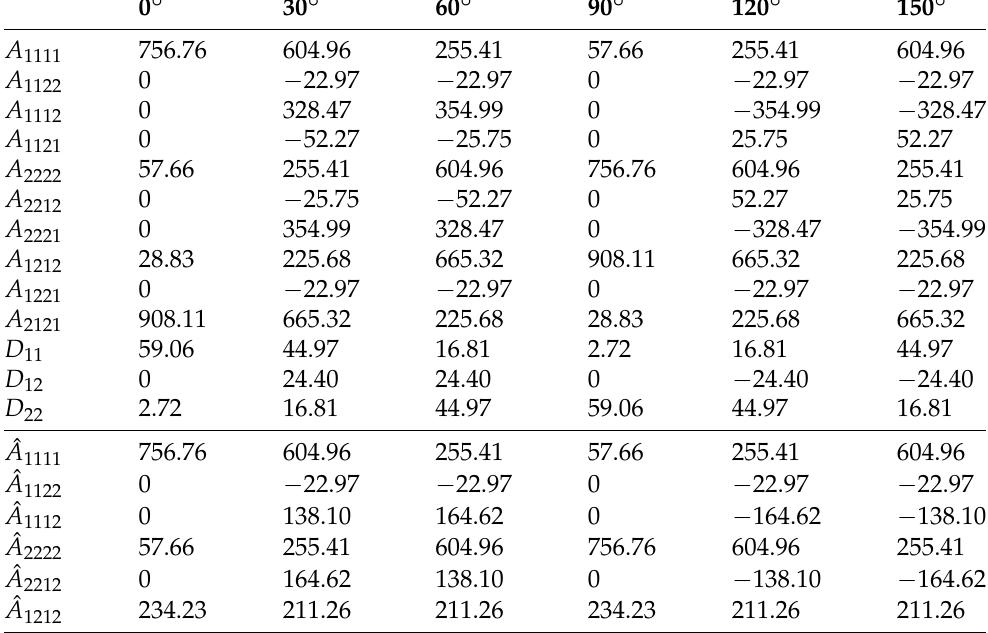
Table 3. Cosserat and Cauchy constitutive parameters for RVE with block parameter ρ = 7, A ijkl , ˆ A